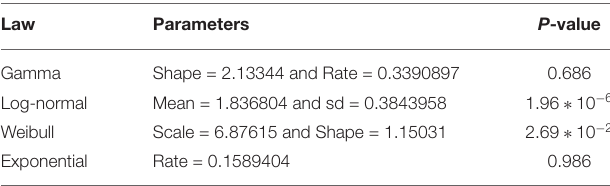
TABLE 1 | Explicit fitted parameters by the method of moments and Kolmogorov-Smirnov